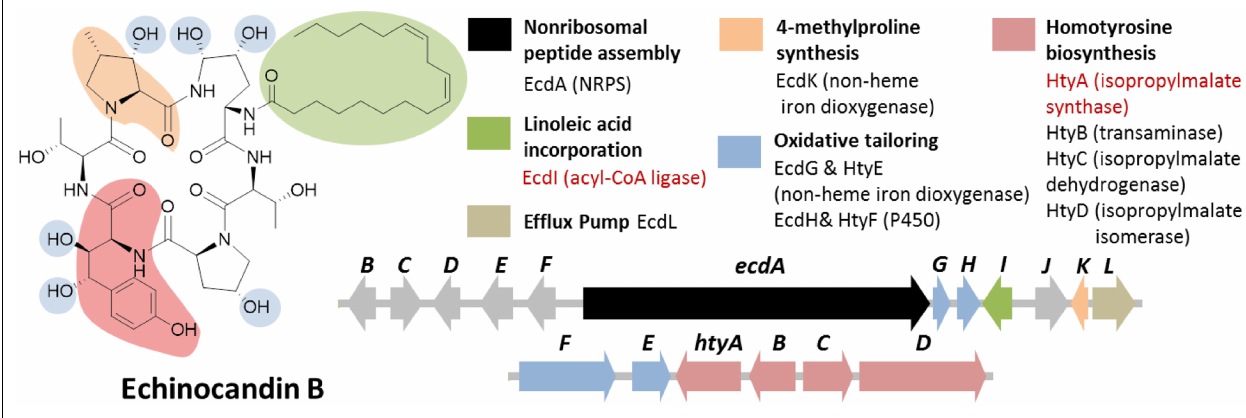
involved in the biosynthesis of a lipo-hexapeptide SM. The separate homotyrosine biosynthesis hty gene cluster at a different locus was located by searching for an isopropylmalate synthase (IPMS) homolog (in red text).